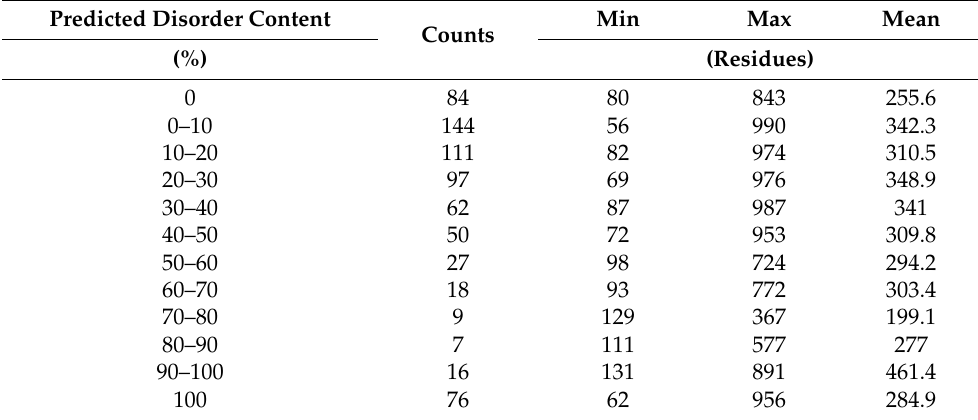
Table 1. Heat-stable proteins with different predicted disorder content. A total of 701 protein sequences were retrieved from UniProtKB/Swiss-Prot. The prediction was performed by MFDp2. The table shows protein counts and other information (Min = minimum, Max = maximum, Mean of length of residues in each group of predicted disorder content). Predicted Disorder